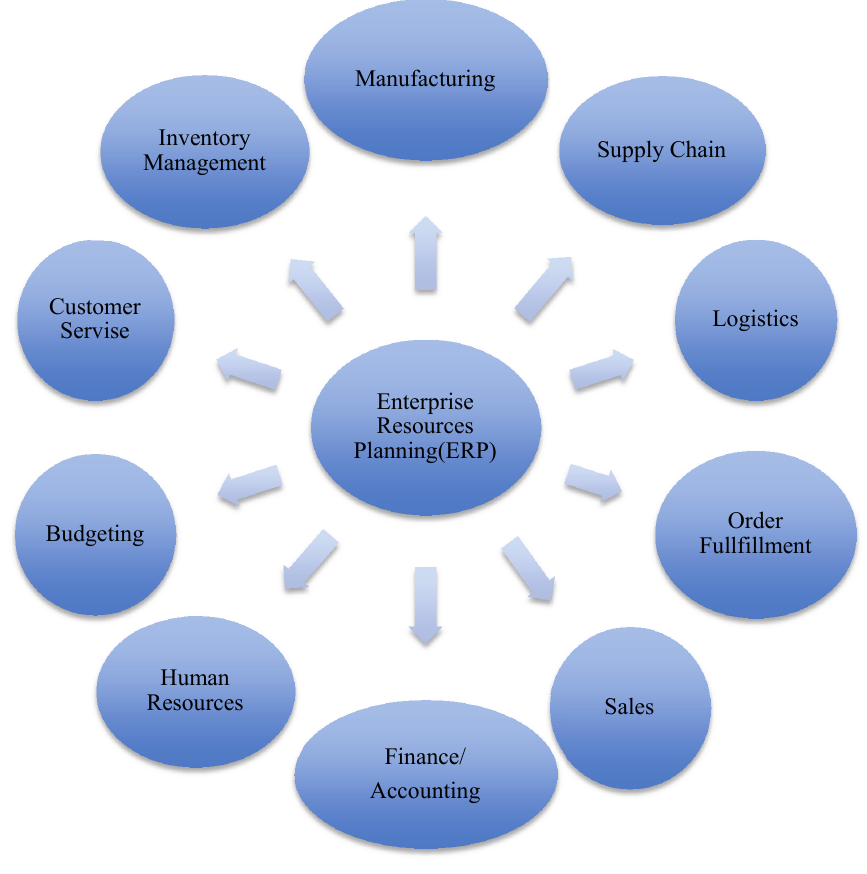
Fig. 1. Components of an ERP